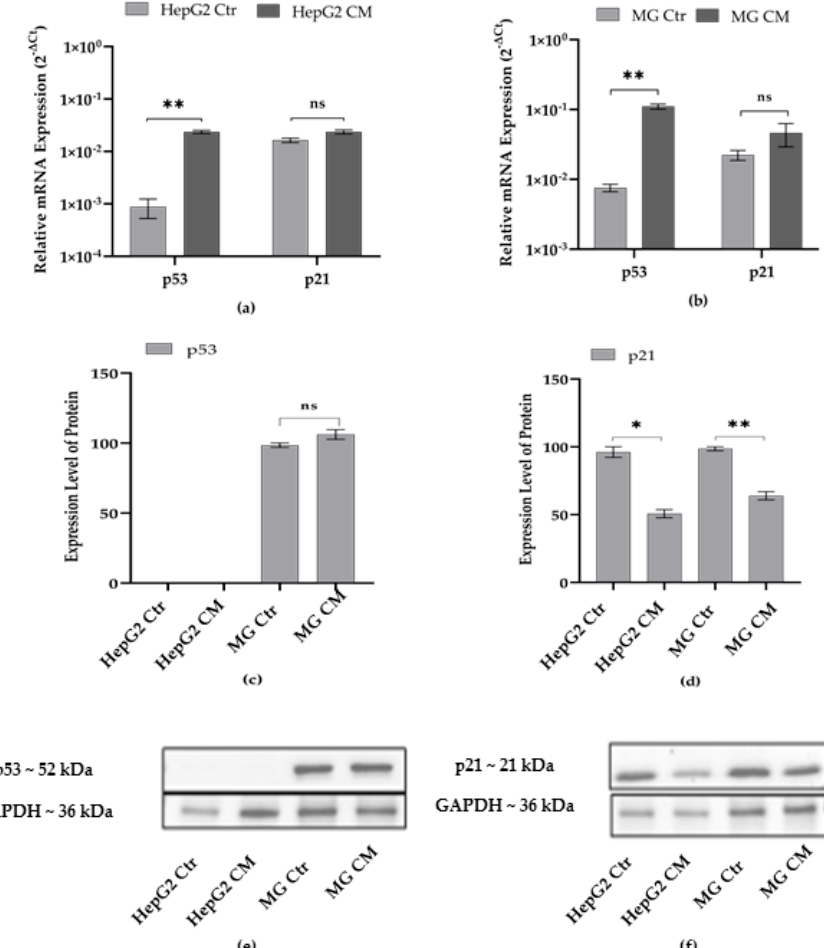
Figure 6. Effect of conditioned media on expression levels of p53 and p21. Transcript and protein expression levels were evaluated in HepG2 ( a , c ) and HMC-III cells ( b , d ) grown for 48 h in condi- tioned (HepG2 CM and MG CM, respectively) and own-culture medium (HepG2 Ctr and MG Ctr, respectively). Transcript levels are expressed as 2 −Δ Ct and presented as the mean ± SEM of at least three different experiments. The protein levels were normalized with GAPDH; then, for each cell-type grown in conditioned medium (CM), data refer to the corresponding control cells grown in their own culture medium (Ctr), set to 100%. ( e , f ) Representative western blots. Results are ex- pressed as the mean ± the standard error of three independent experiments. Statistical analysis was performed by using t -test; * p <0.05, ** p <0.01; control (Ctr) cells vs. media conditioned (CM) cells; ns: not significant p -value.